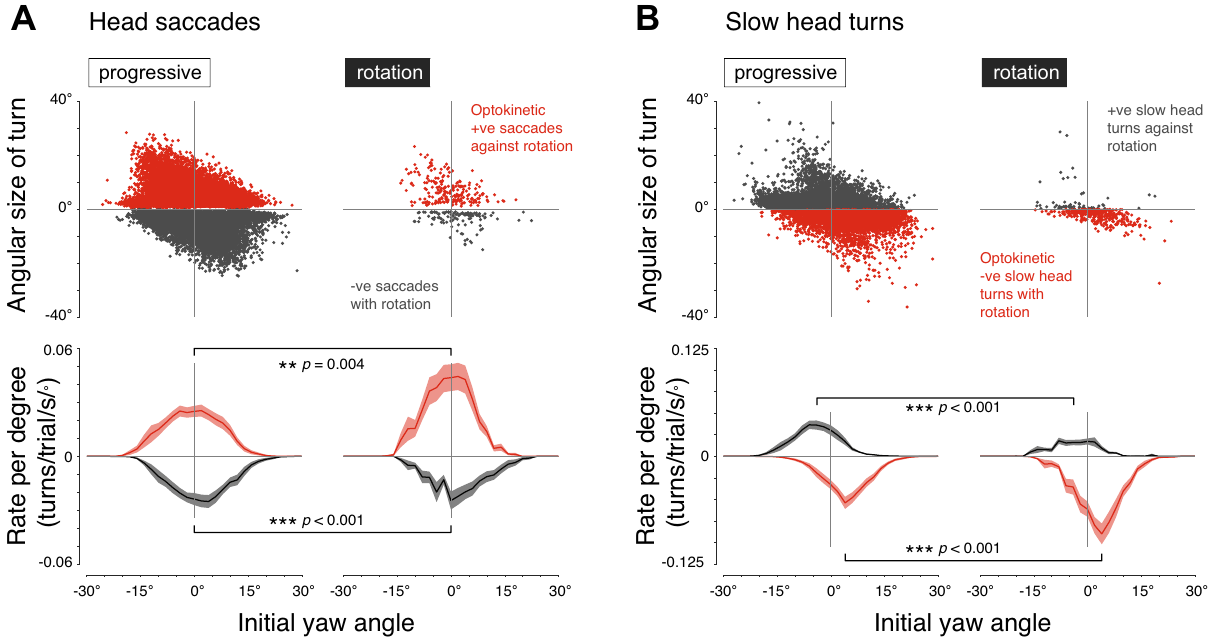
Figure 3. Rotational image motion selectively recruits OKN-like head movements. ( A ) Properties of saccadic head turns during progressive image motion of all the pre-stimulus conditions (Left) and during rotational image motion of the 4, 7 and 10 Hz stimulus conditions (Right). Top: the angular size of all positive (red— indicating optokinetic head movement) and negative (black—indicating anti-optokinetic head movement) head saccades, as a function of the initial yaw angle at the start of the turn. N = 18 flies. Bottom: the rate of head saccades per trial per second per degree, as a function of the initial yaw angle at the start of the turn. Asterisks and p values indicate significance of statistical comparisons of the rate of saccades per trial per second for all initial angles (paired t -tests, N = 18; ** p < 0.01, *** p < 0.001). ( B ) Properties of slow head movements, from the same data and using the same plotting conventions as in ( A ). Here, negative slow movements with the direction of motion are plotted in red—indicating optokinetic head movements—and positive slow movements are plotted in black—indicating anti-optokinetic head